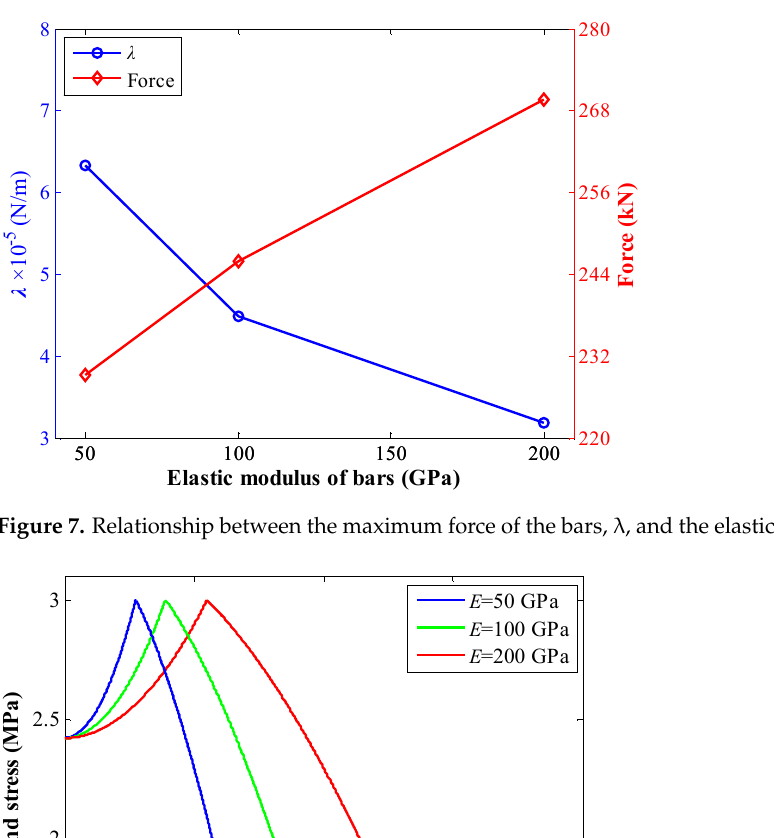
Figure 7. Relationship between the maximum force of the bars, λ , and the elastic modulus of the